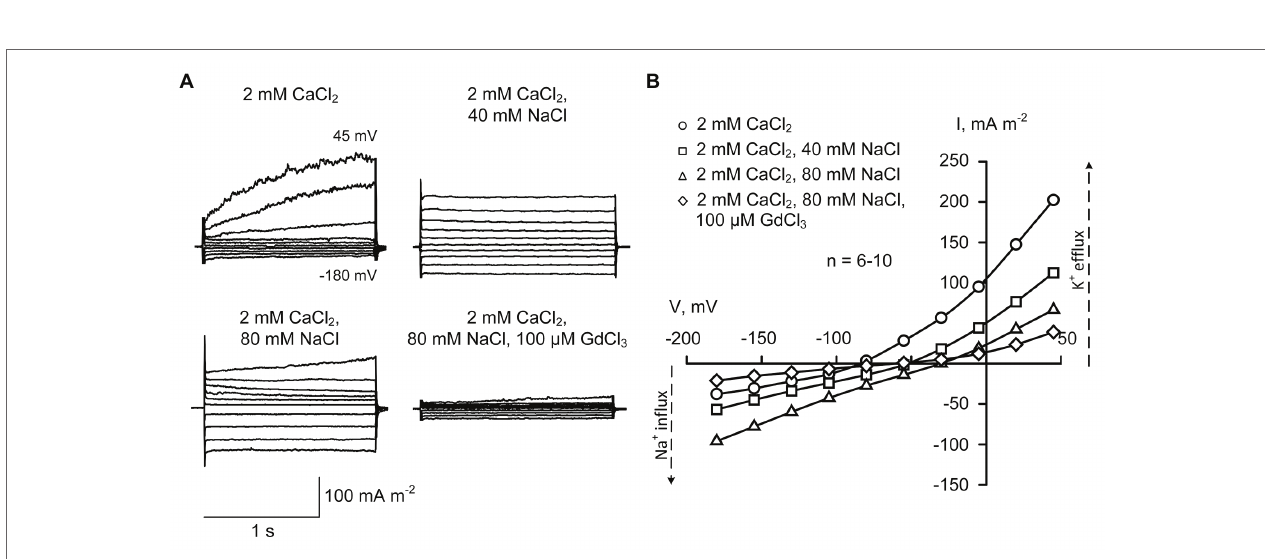
FIGURE 2 | Typical plasma membrane currents (A) and mean current-voltage curves (B) in Helianthus annuus L. root protoplasts recorded in the presence of 20 mM CaCl 2 in the bathing solution at different levels of external NaCl (40 and 80 mM). Current-voltage curves were plotted by mean values ( n = 7–11; errors are not shown in the figure). Statistically significant ( p < 0.01) difference between mean currents was found at voltage values exceeding − 30 mV (ANOVA test). The standard bathing solution contained (in mM): 0.3 KCl, 2 Tris, adjusted to pH 6.0 with 1 MES, and 600 mOsM, with D-sorbitol. The pipette solution contained 70 mM K gluconate, 10 mM KCl; 100 nM Ca 2+ was adjusted with 1 mM BAPTA and 0.475 mM CaCl 2 , pH 7.2 with 2 mM Tris, 1 mM